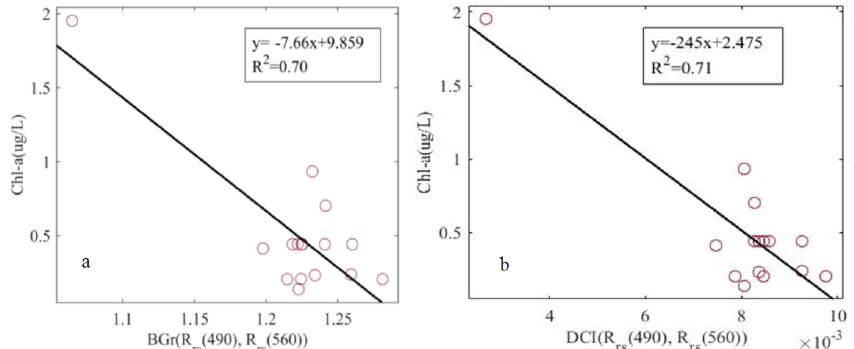
Figure 9. Scatterplots of the Chl-a concentration as a function of ( a ) BGr calculated by R rs (490) and R rs (560), and ( b ) DCI calculated by R rs (490) and R rs